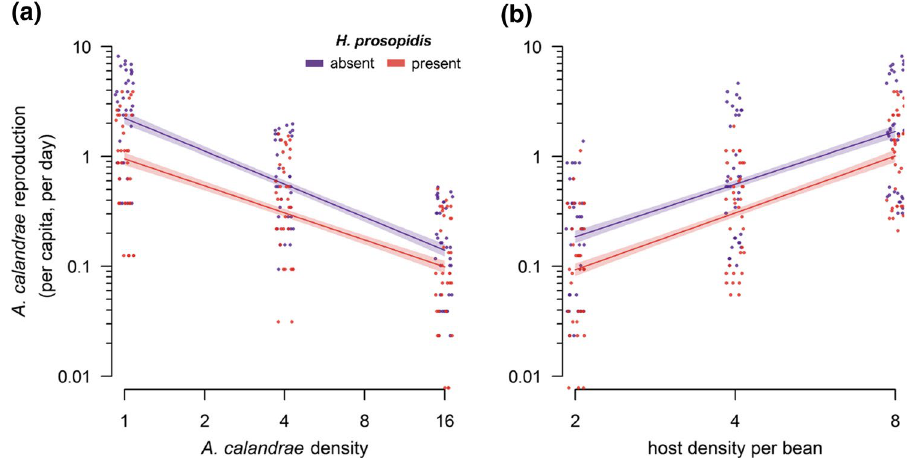
Figure 1. The number of emerged offspring of the native parasitoid Anisopteromalus calandrae (per female, per day) in the presence (red) and absence (purple) of the nonnative parasitoid Heterospilus prosopidis as a function of ( a ) A. calandrae density and the presence of H. prosopidis ( p < 0.001 for the interaction between A. calandrae density and presence of H. prosopidis ) and ( b ) host density ( p < 0.001). Lines depict the general linear model fit (with shaded 95% CI). A small positive or negative random number (jitter) was added to the x- coordinate of each data point for graphical clarity.